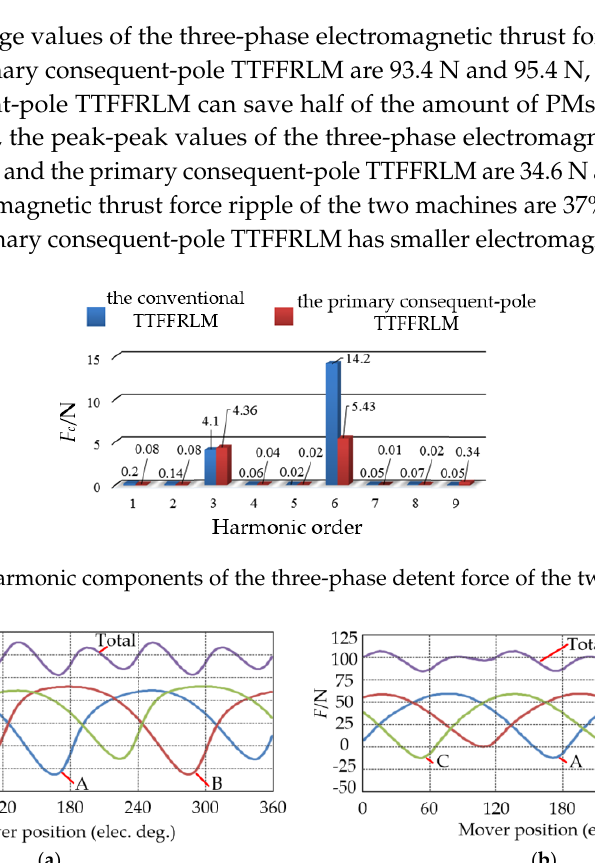
Figure 14. The waveform of the electromagnetic thrust force at 7.5 A: ( a ) The conventional TTFFRLM; and, ( b ) The primary consequent-pole TTFFRLM.